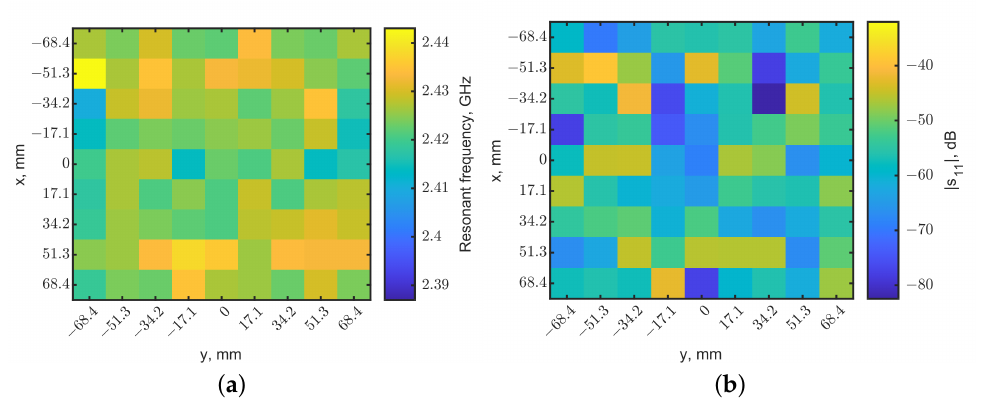
Figure 7. Localization maps generated from ( a ) resonant frequencies and ( b ) reflection-coefficient magnitudes for the case without a tumor. The color scales are the same as the ones in Figure